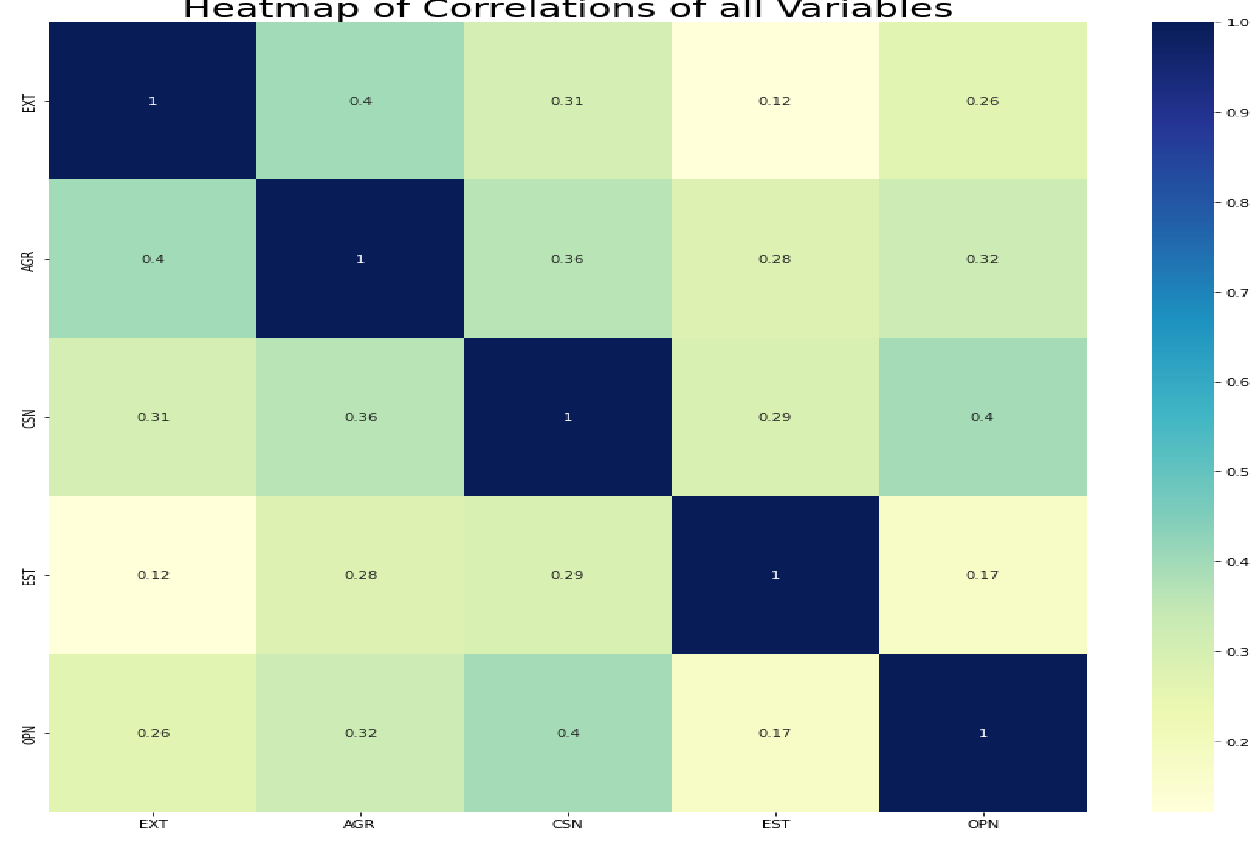
Figure 4. Correlations between personality traits.